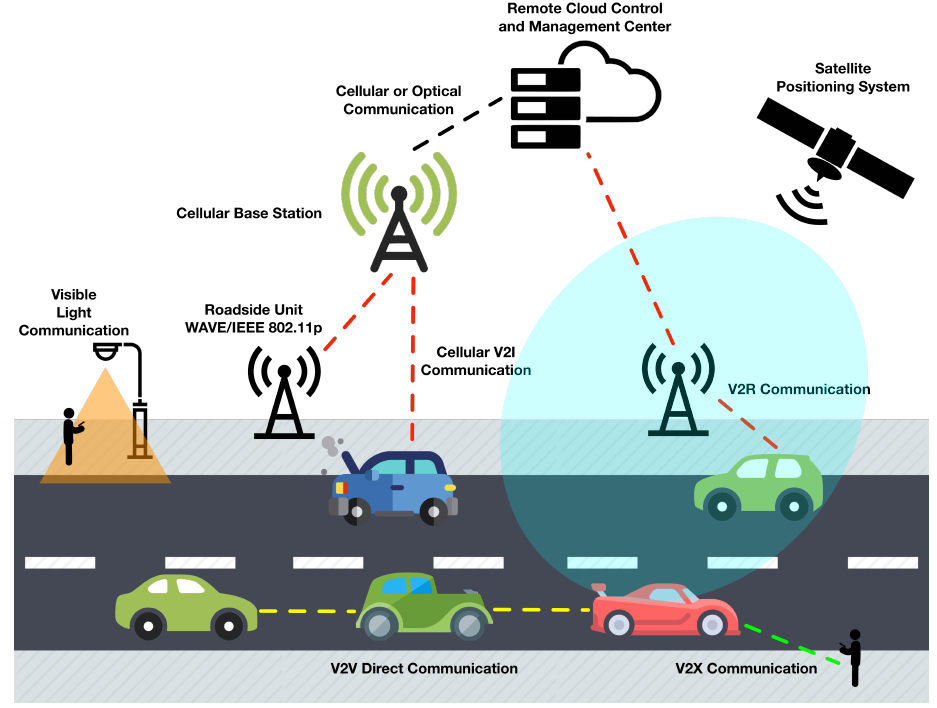
Figure 2. V2V, V2I, and V2X